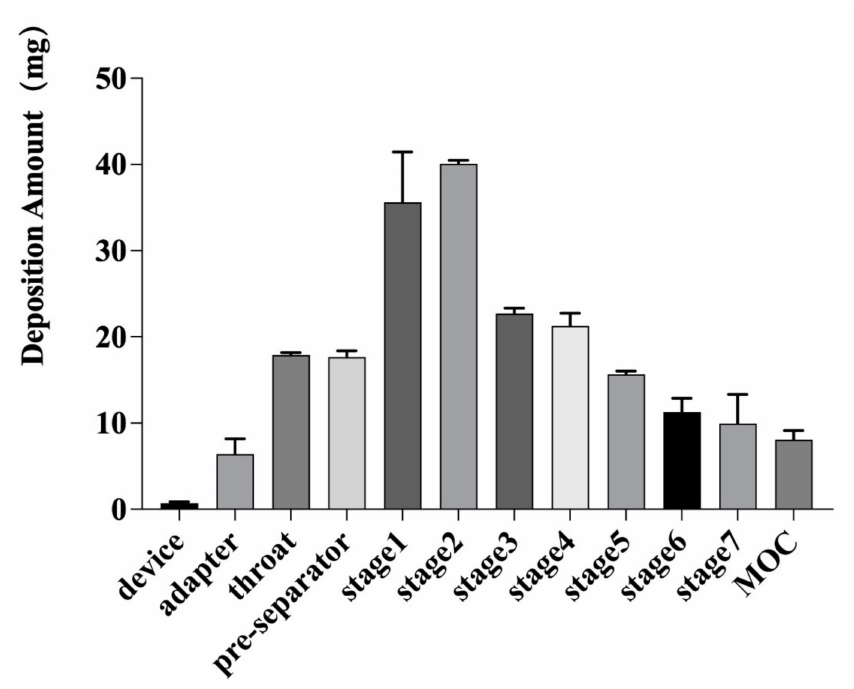
Figure 4. Dissemination amount of the GM spray-dried powders from each part of the NGI (device (HandiHaler ® DPI, Boehringer Ingelheim Pharm GmbH&Co. KG, Ingelheim, Germany), adapter, throat, pre-separator, stages 1–7, and micro-orifice collector (MOC)) ( n = 3). Cutoff sizes for the NGI at a flow rate of 30 L/min were 11.7, 6.4, 3.99, 2.3, 1.36, 0.83, and 0.54 µ m for stages 1–7 and the MOC, respectively